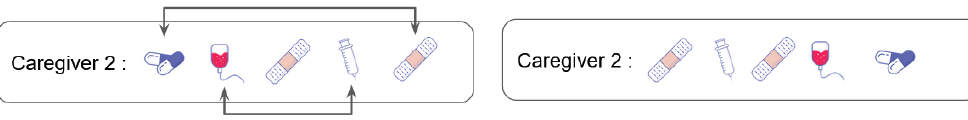
Figure 11. Patient neighborhood moves.